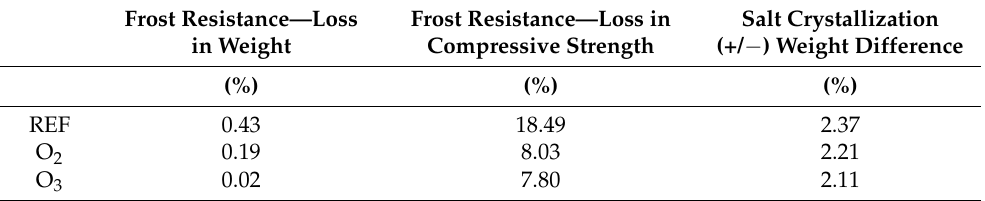
Table 6. Durability properties of the tested concretes.